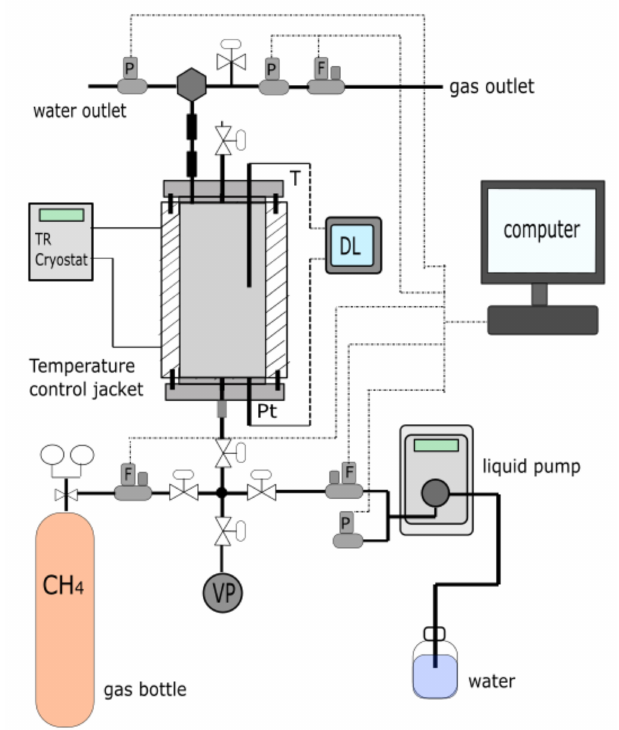
Figure 2. Schematic diagram of the experimental apparatus. (DL) Data logger, (P) Pressure regulator, (F) Mass flow regulator, (Pt) Pressure transducer, (T) Thermocouple, (TR) thermal regulator, (VP) Vacuum Pump,( ) high-pressure filter for gas-liquid separator, ( ) high pressure 0.5 µ m